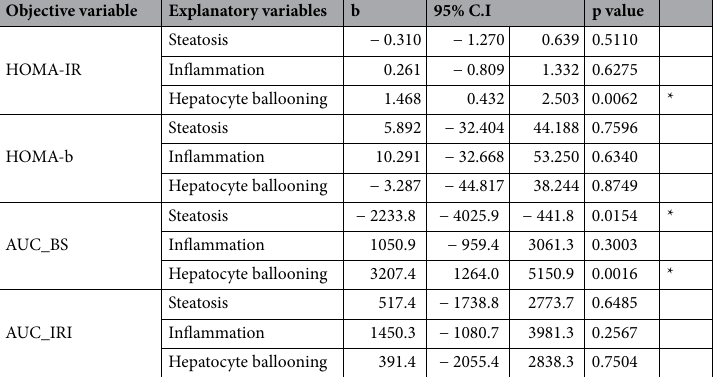
Table 1. Linear regression analysis of glucose metabolic markers using histological findings of the liver in patients who underwent metabolic surgery. HOMA homeostasis model assessment, IR insulin resistance; AUC area under curve; BS plasma sugar; IRI serum